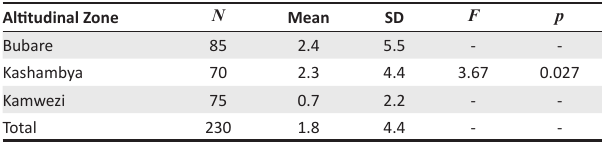
TABLE 2: Comparative exposure index of the altitudinal zones.